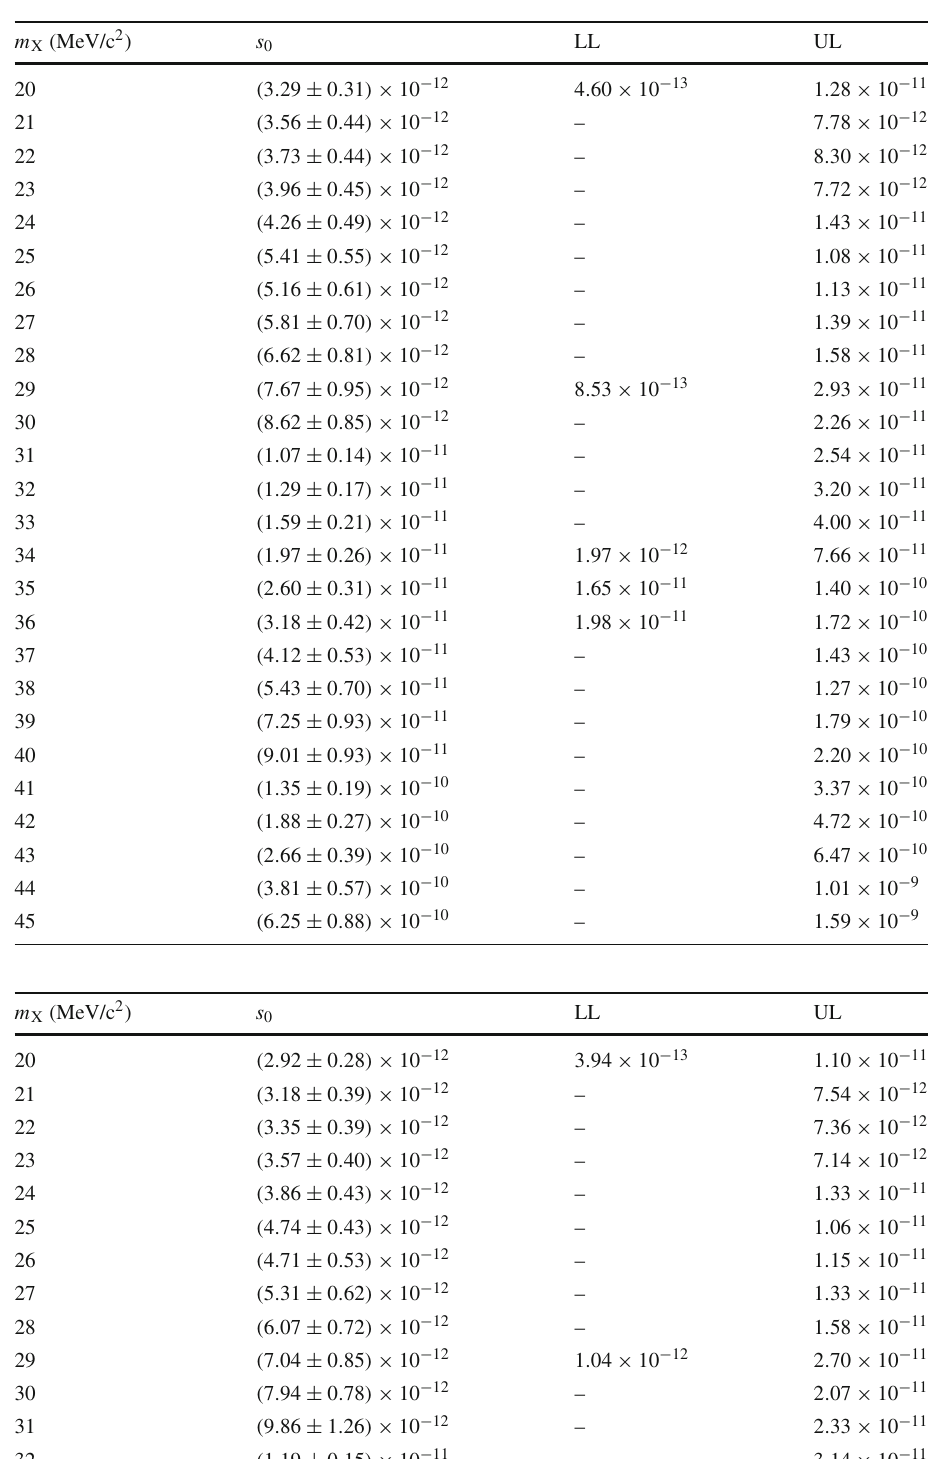
Table 3 Results for τ X = 5 ps.